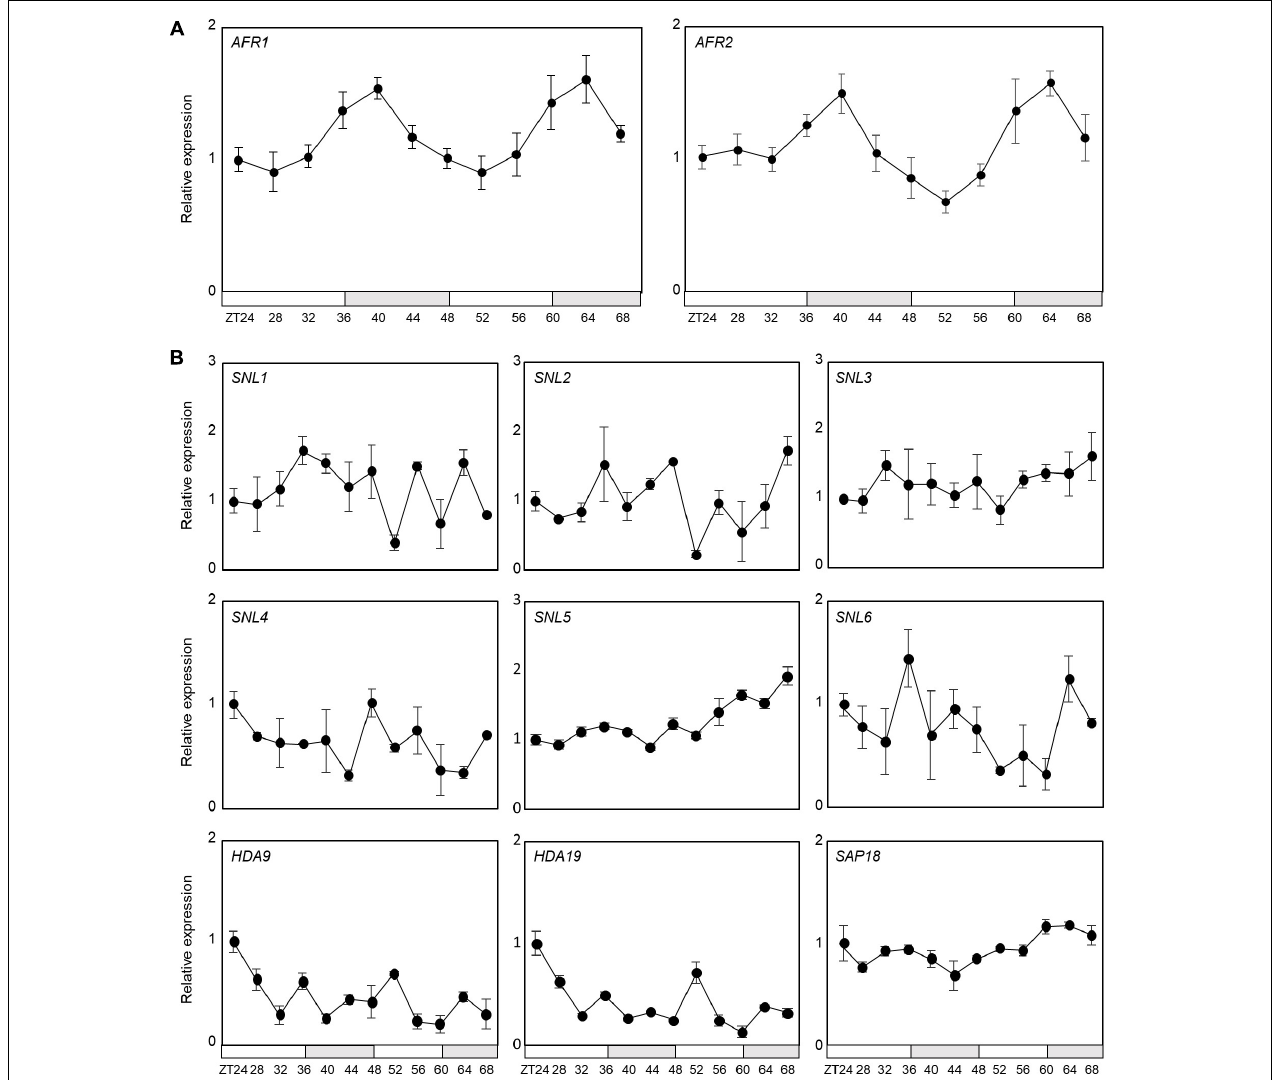
FIGURE 1 | Circadian expression of AFR1 and AFR2 . Seedlings grown under neutral day conditions (ND, 12 h light: 12 h dark) for 2 weeks were transferred to continuous light conditions (LL) at Zeitgeber Time 0 (ZT0). Whole seedlings were harvested from ZT24 to ZT68 to analyze transcript accumulation. Transcript levels were determined by quantitative real-time RT-PCR (RT-qPCR). Gene expression values were normalized to EUKARYOTIC TRANSLATION INITIATION FACTOR 4A1 ( eIF4A ) expression. Three independent biological replicates were averaged. Bars represent the standard error of the mean. The white and gray boxes indicate the subjective day and night, respectively. (A) Expression of AFR1 and AFR2 . (B) Expression of other components of